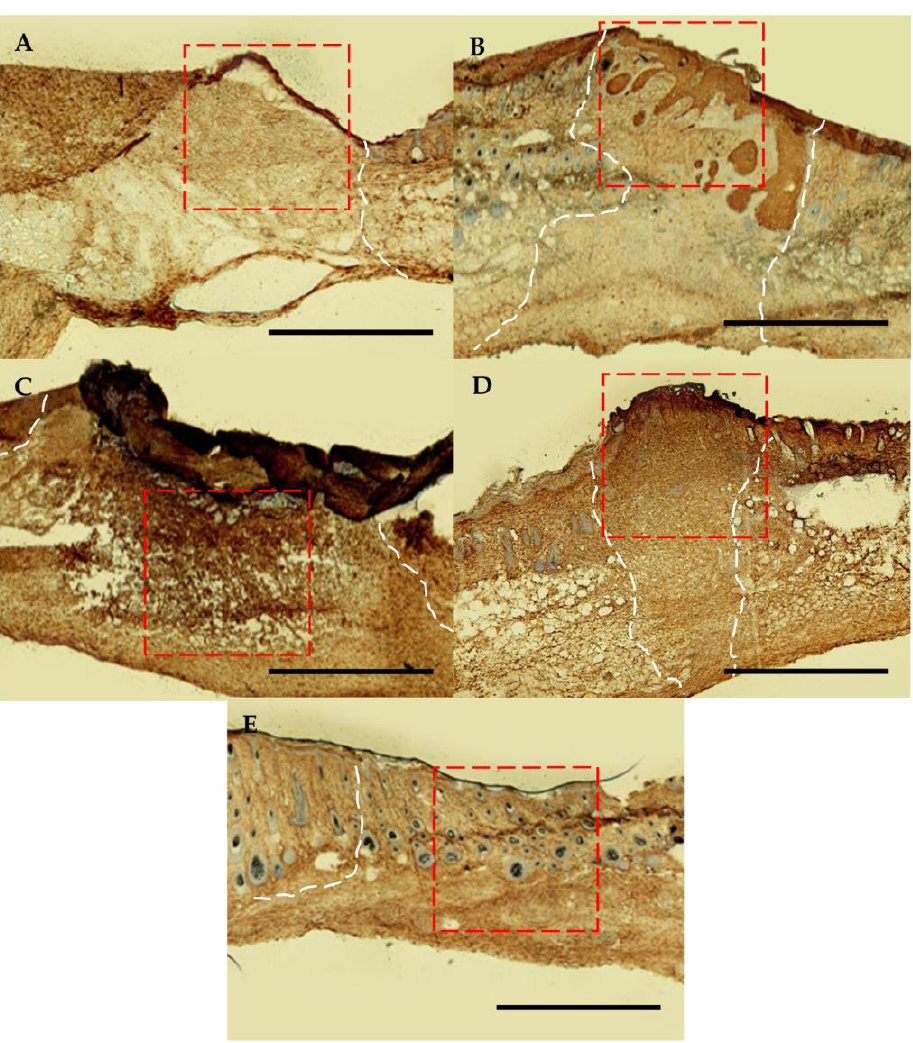
Figure 10. Representative keratin-6 histological staining images of the harvested tissue at day 7 of control ( A ), PEG-D4-Si ( B ), PEG-D6-Si ( C ), PEG-D8-Si ( D ), and PEG-D6 ( E ). Red dash line indicates the area used to calculate keratinocyte content. White dash line indicates the wound proximities. Scale bars are 1 cm.